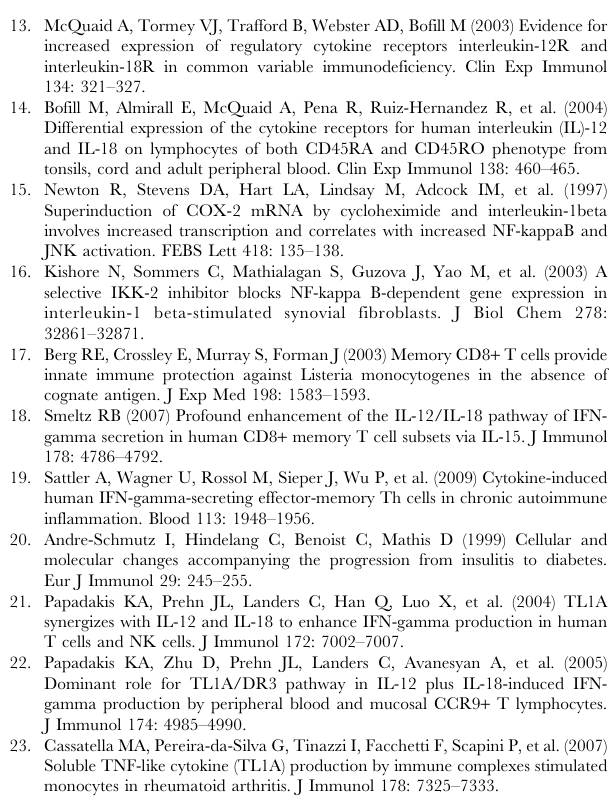
Figure S1 Human peripheral blood CD4 + T cells from two independent donors were activated with either anti- CD3 plus anti-CD28 or IL-12 plus IL-18 in the presence or absence of cyclosporin A for 24 hours and the supernatants were analyzed for IFN- c production. Results from two independent donors are shown here. Figure S2 Freshly isolated human peripheral blood CD4 + T cells were stimulated with the indicated